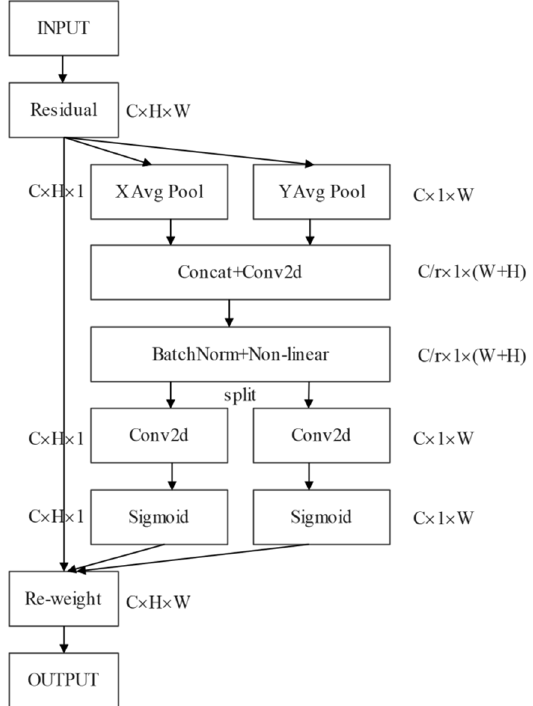
Figure 5. Structure diagram of the coordination attention mechanism [55]. X Avg Pool is 1D horizontal global pooling. Y Avg Pool is 1D vertical global pooling.